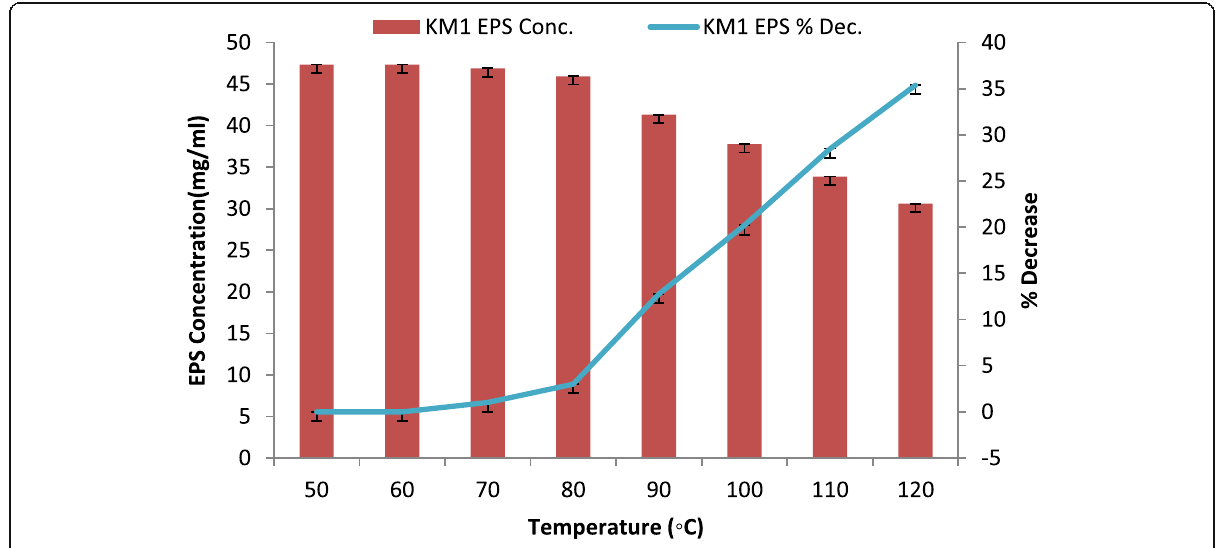
Fig. 3 Effect of high temperature resistance on purified EPS concentration